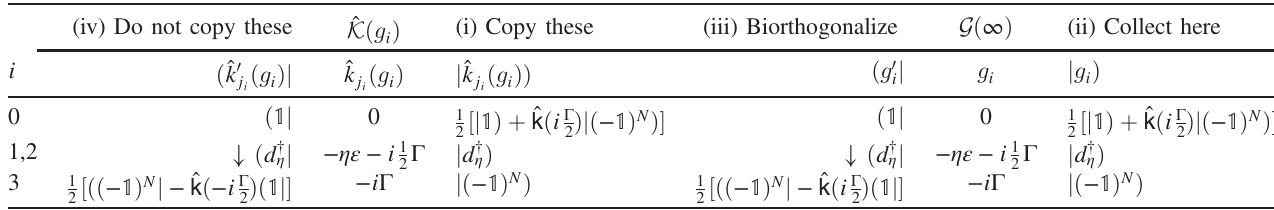
ˆ K TABLE III. Sampling of memory kernel ð ω Þ by the stationary generator G ð ∞ Þ [Eq. (21)]. Left-hand columns: for each different ˆ K superoperator ð g i Þ we list one pole eigenvalue with its left and right eigenvector. Right-hand columns: collecting the right eigenvectors ˆ K from ð g i Þ and biorthonormalizing, we construct the left eigenvectors ð g 0 j . Row i ¼ 1 , 2 corresponds to η ¼ (cid:5) i